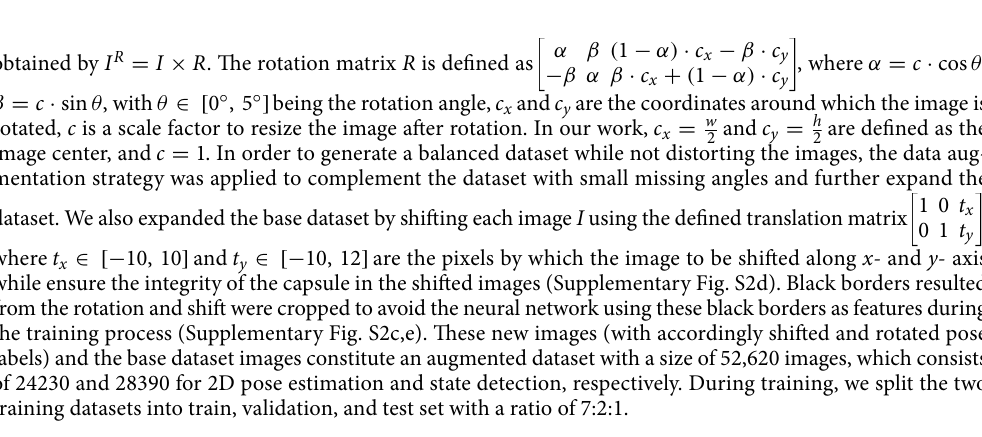
Figure 6. The hierarchical neural network. ( a ) depicts the hierarchical architecture and the workflow and ( b ) demonstrates the neural network architecture of the three